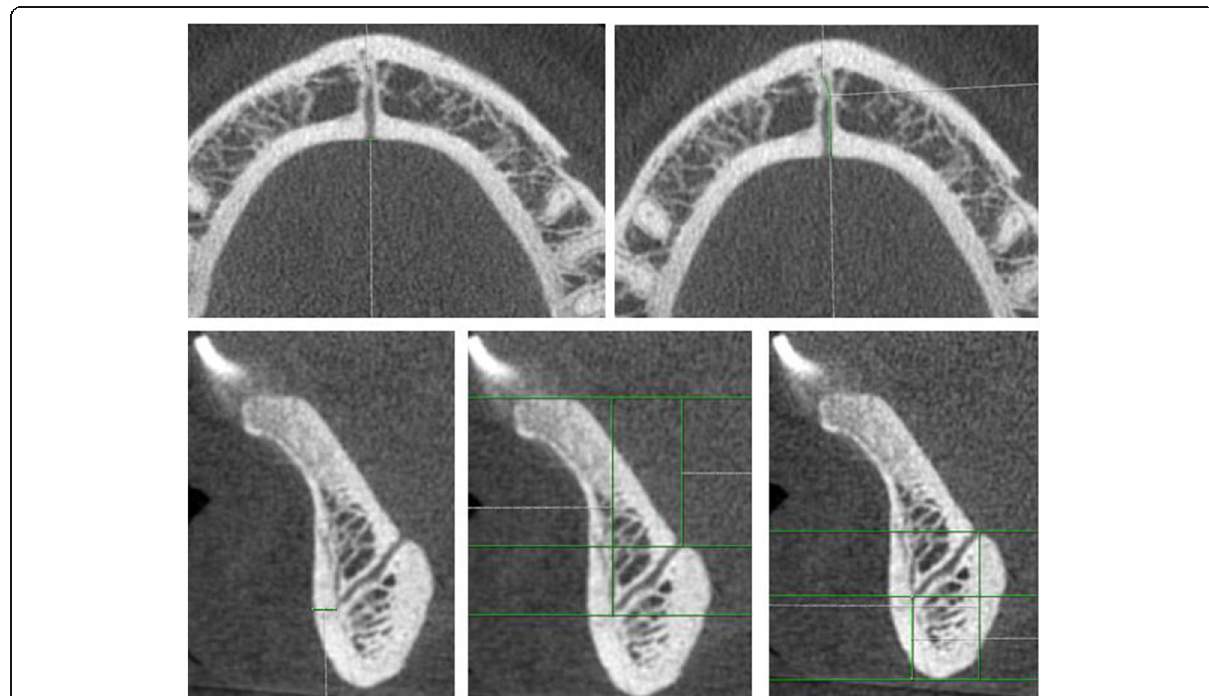
Fig. 2 CBCT measurements in 21-year-old male patient